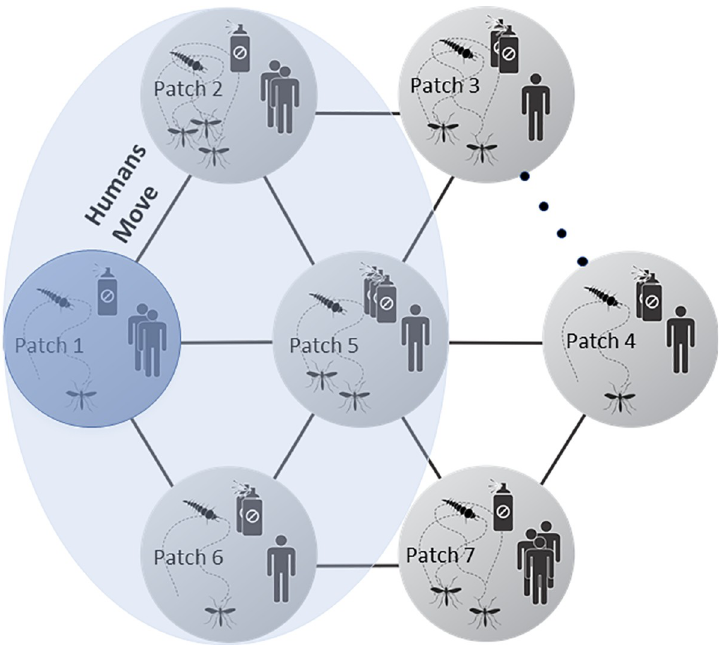
Fig 1. The structure of human metapopulation with mosquito controls where control strength in each patch (e.g., focal patch 1) is based on human infections at a local scale (focal patch only in dark blue), regional scale (focal and neighbor patches: in blue) and global scale (all patches). The dots between Patch 3 and 4 represent the potential patches in the system.